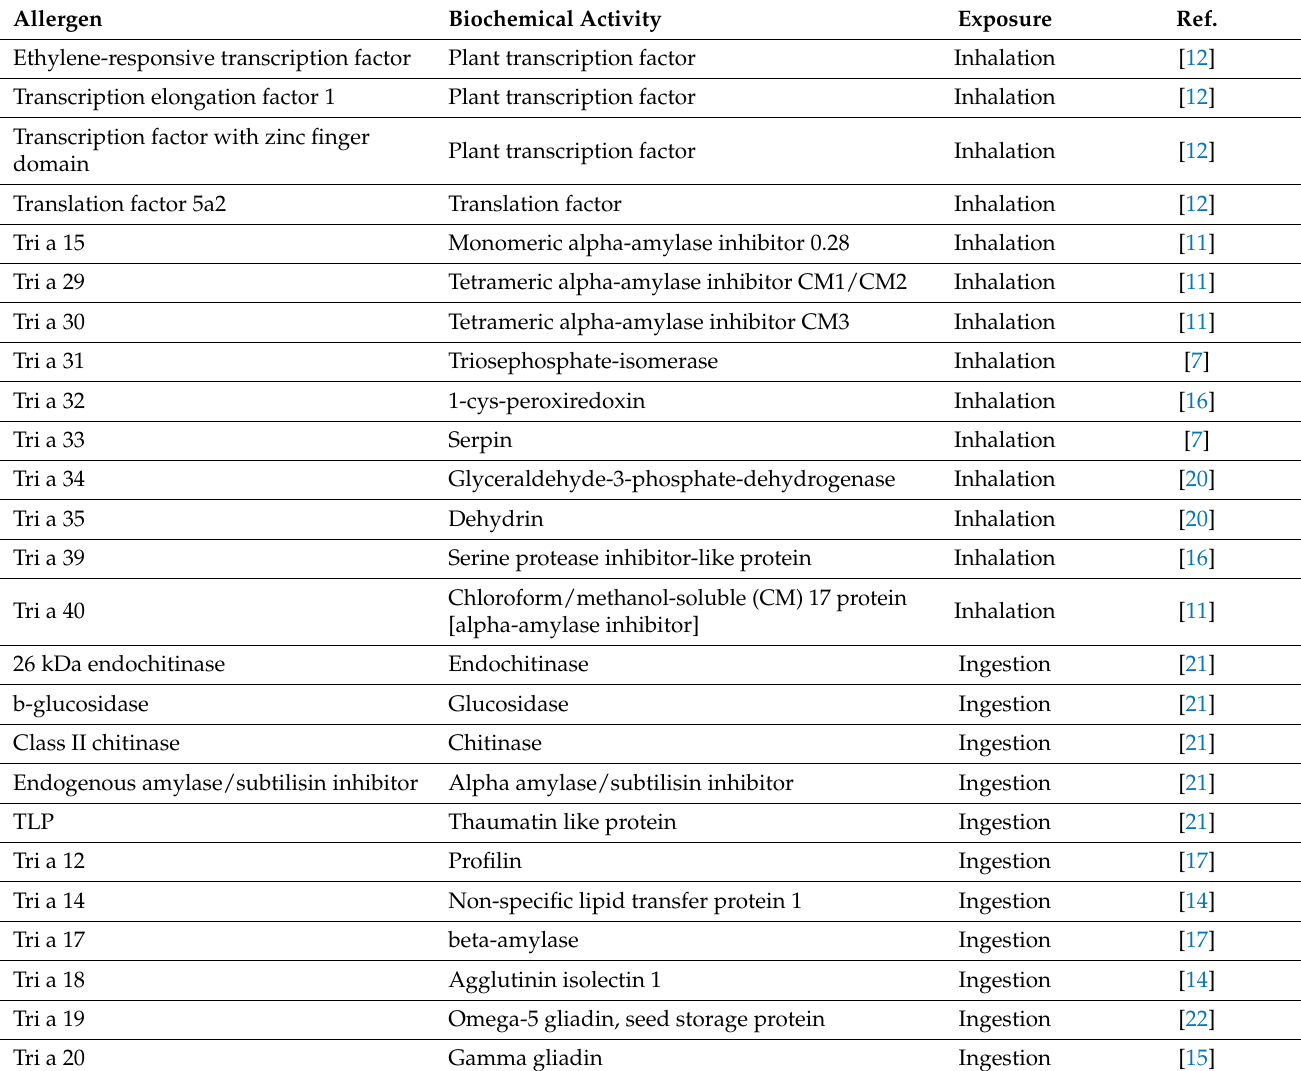
Table 1. Biochemical activities and route of exposure of wheat allergens. Biochemical Activity Exposure